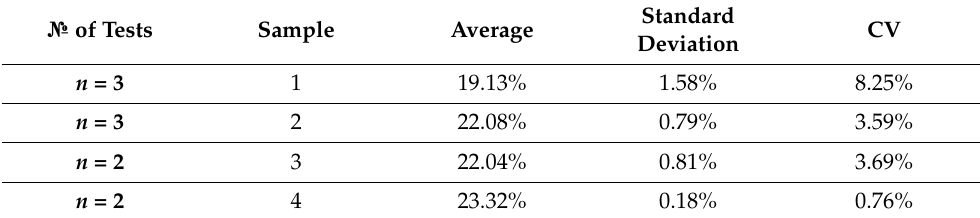
Table 3. Results for 2.00